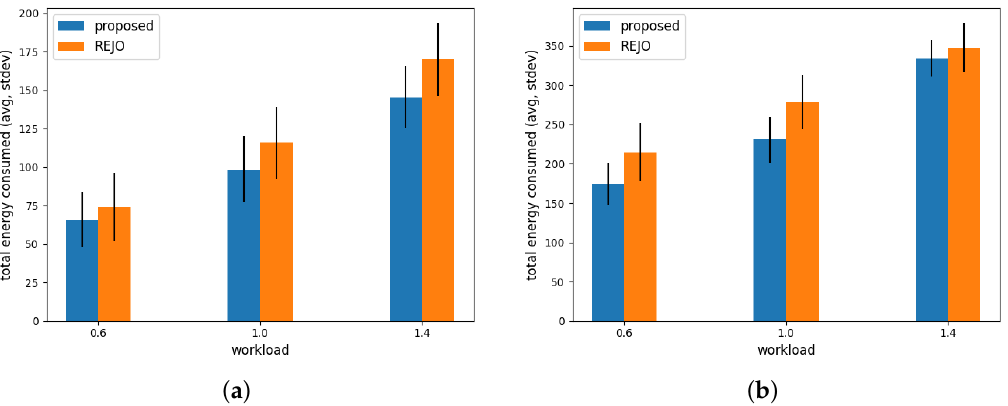
Figure 3. Comparison of energy consumption in a MEC system. ( a ) 10 MECSs; ( b ) 20 MECSs.